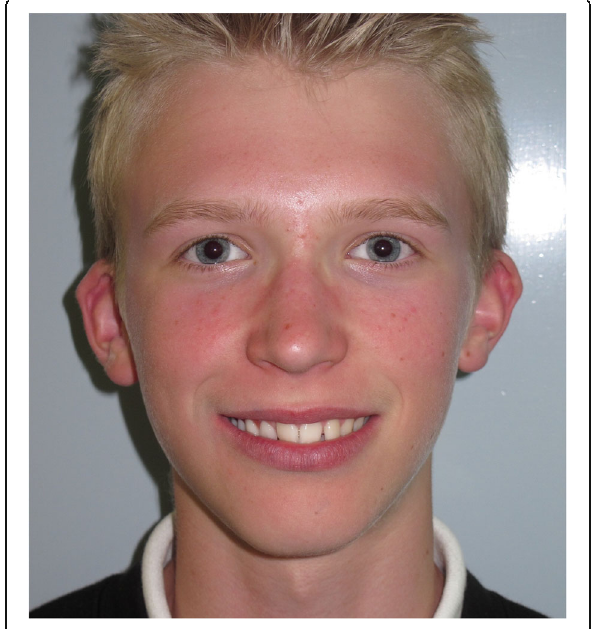
Fig. 10 Full facial view of definitive implant-retained obturator at initial fitting (April 2014)